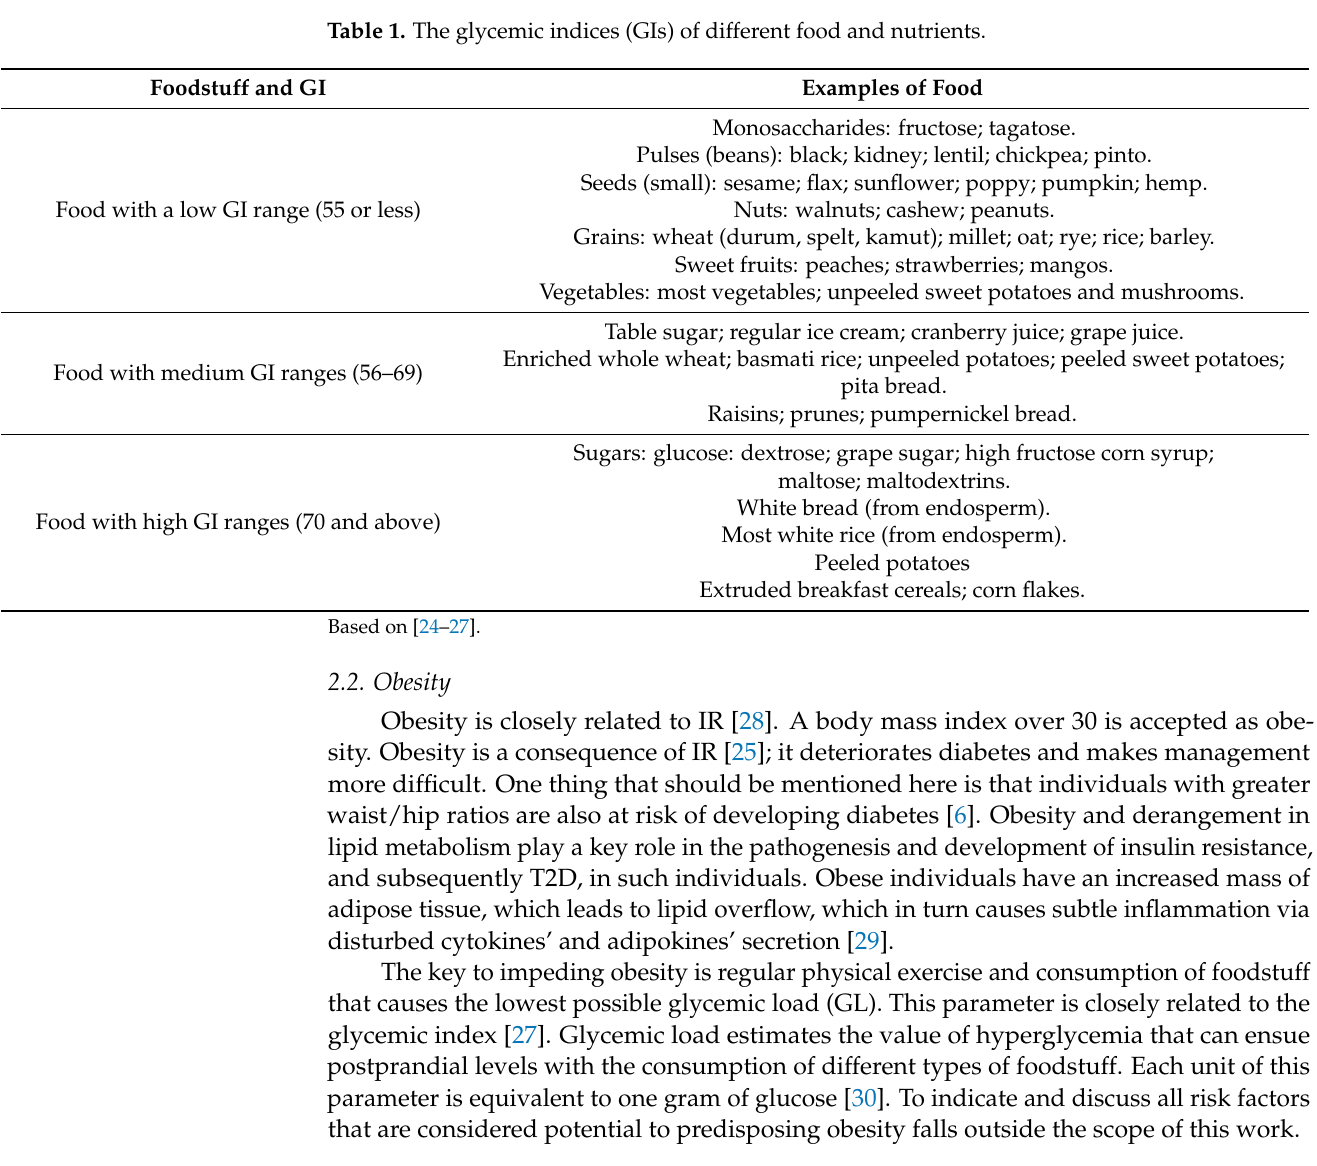
Table 1. The glycemic indices (GIs) of different food and nutrients. Foodstuff and GI Examples of Food Monosaccharides: fructose; tagatose.